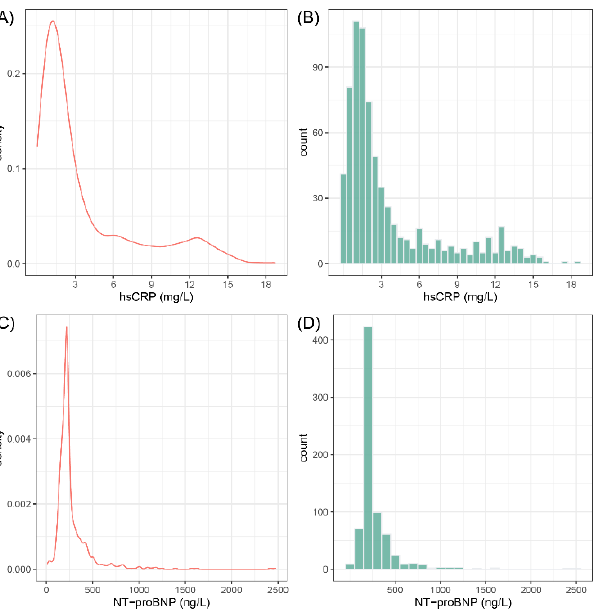
Figure A1. Density plots and histogram of hsCRP and NT-proBNP. hsCRP: ( A , B ). NT-proBNP: ( C , D ).